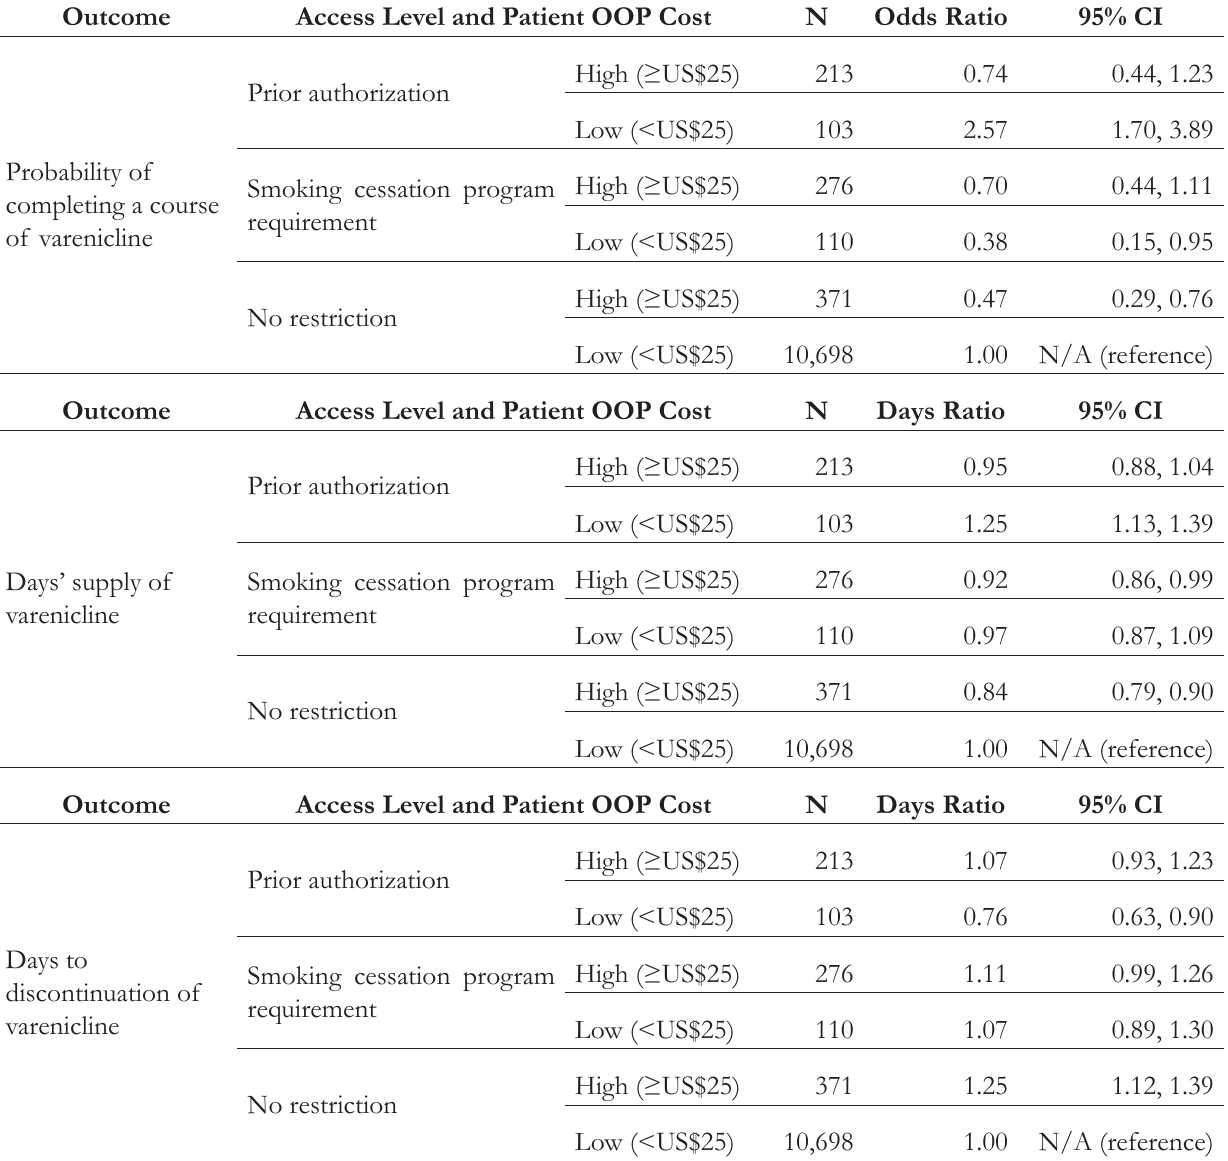
Table 3. Impact of Access Restrictions and Out-of-pocket (OOP) Cost on Varenicline Persistence